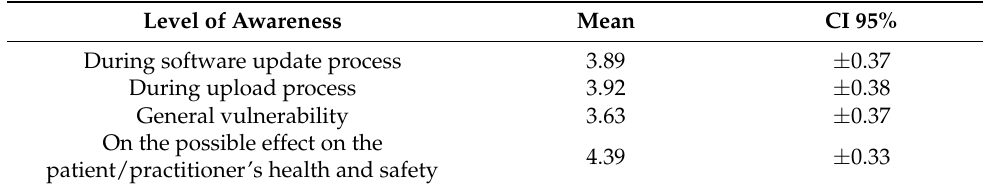
Table 10. Level of awareness in cyber-risk scenarios for LOLI. Level of Awareness Mean CI 95% During software update process 3.88